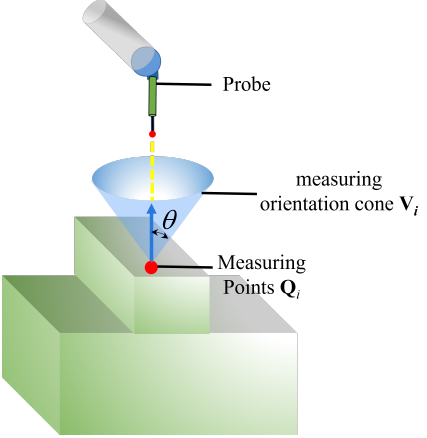
Figure 3. Schematic diagram of measuring orientation